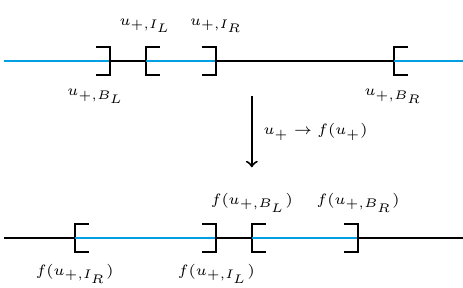
Figure 10 . We can apply a M(cid:127)obius transformation such that the regions are arranged in the way we discussed in section